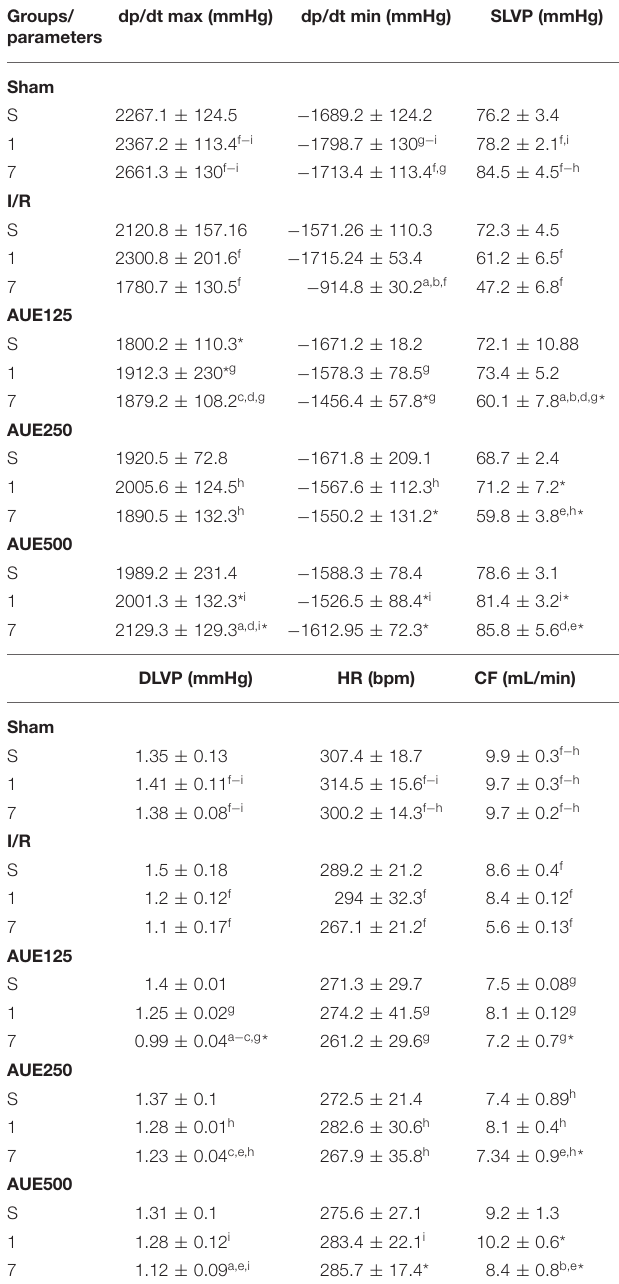
TABLE 1 | Cardiodynamic parameters within and between groups.